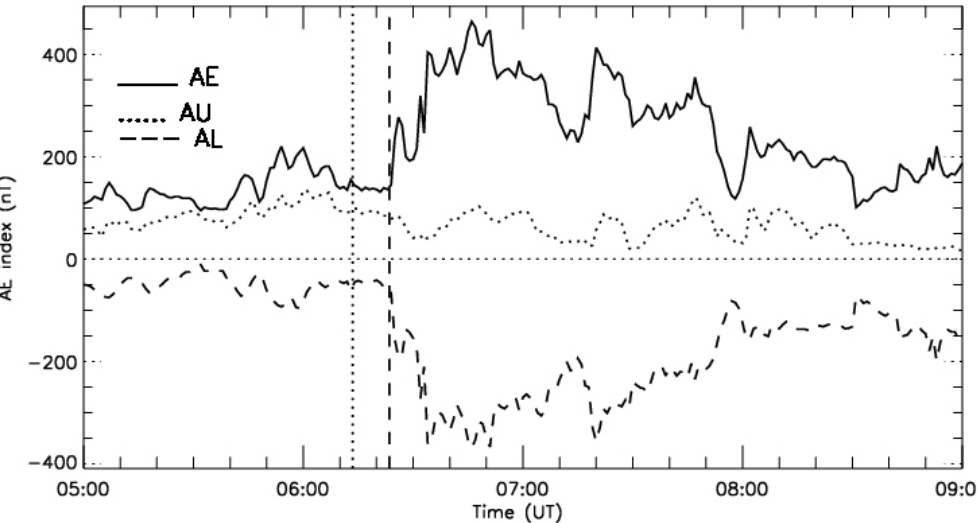
Fig. 2. The AE index in the intervals 05:00–09:00UT on 15 February 2008, the vertical dotted line is marked substorm onset time, 06:14 UT.